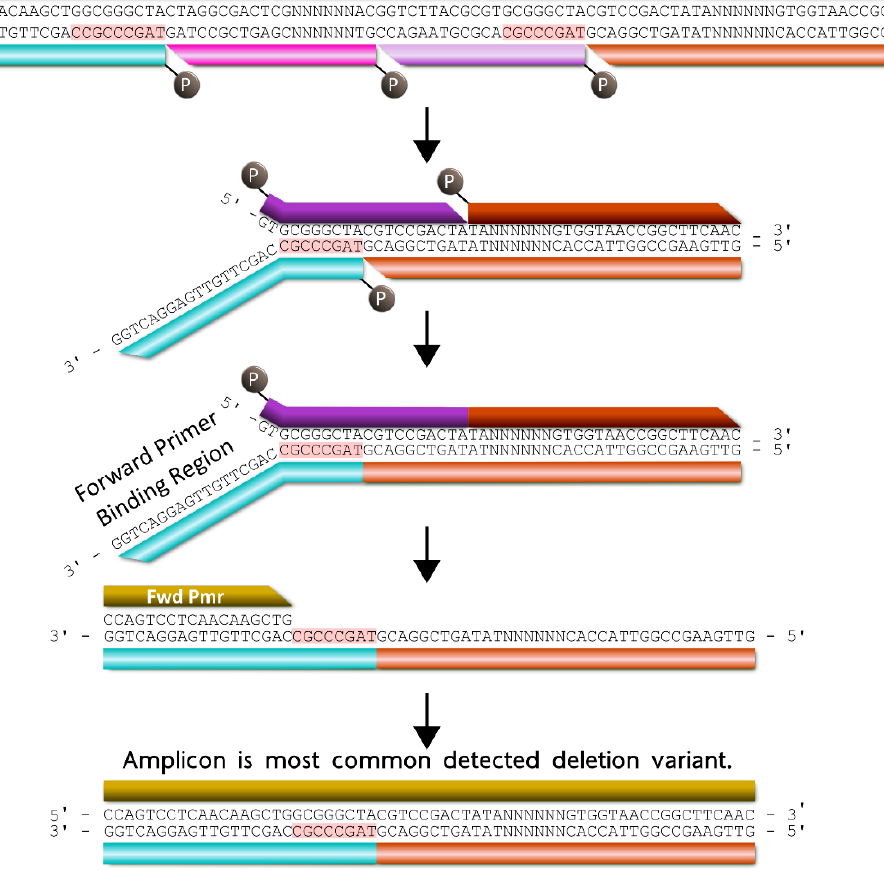
Figure 5. Proposed formation pathway for the highest deletion variant (gold) resulting from identical terminal nucleotides (red highlighted) for block 1 (turquoise) and block 3 (purple) bottom strands. All constant and variable regions across the modular barcode are represented by the colors gray and cyan, respectively. The deletion domain is indicated by the orange highlighted nucleotides. Blocks 2 and 4 are represented by the colors pink and orange respectively. For each block, the darker shade of each color represents the top strand, and the lighter shade of each color represents the bottom